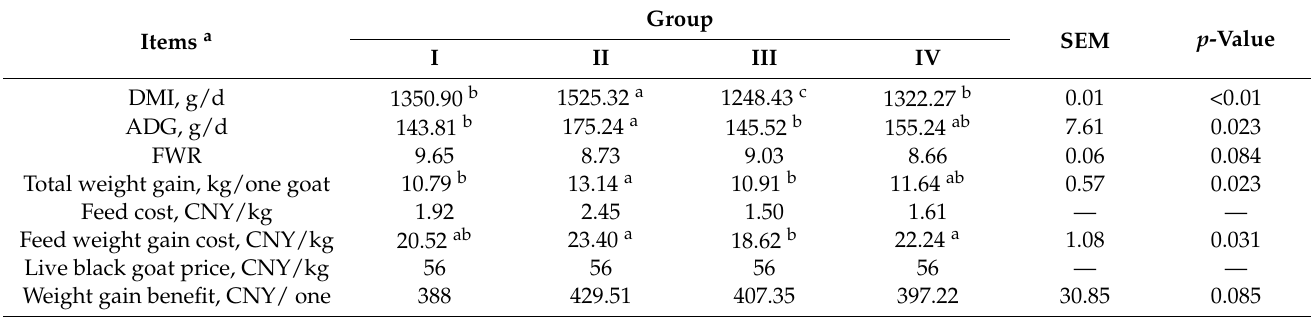
Table 3. Effects of different TMR diets on the performance and economic benefits of black goats.